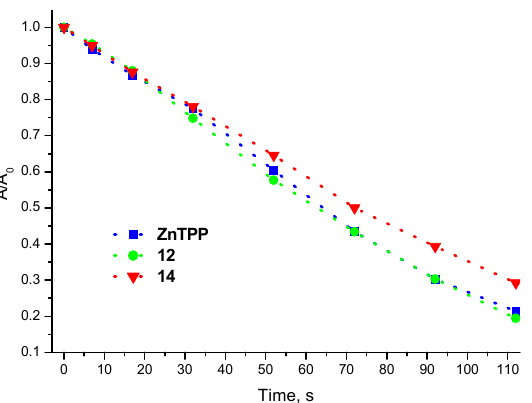
Figure 2. UV-Vis absorption ( a ) and fluorescence ( b ) spectra of ZnТРР, 12 and 14 in DMF ( С = 0.75 μМ).